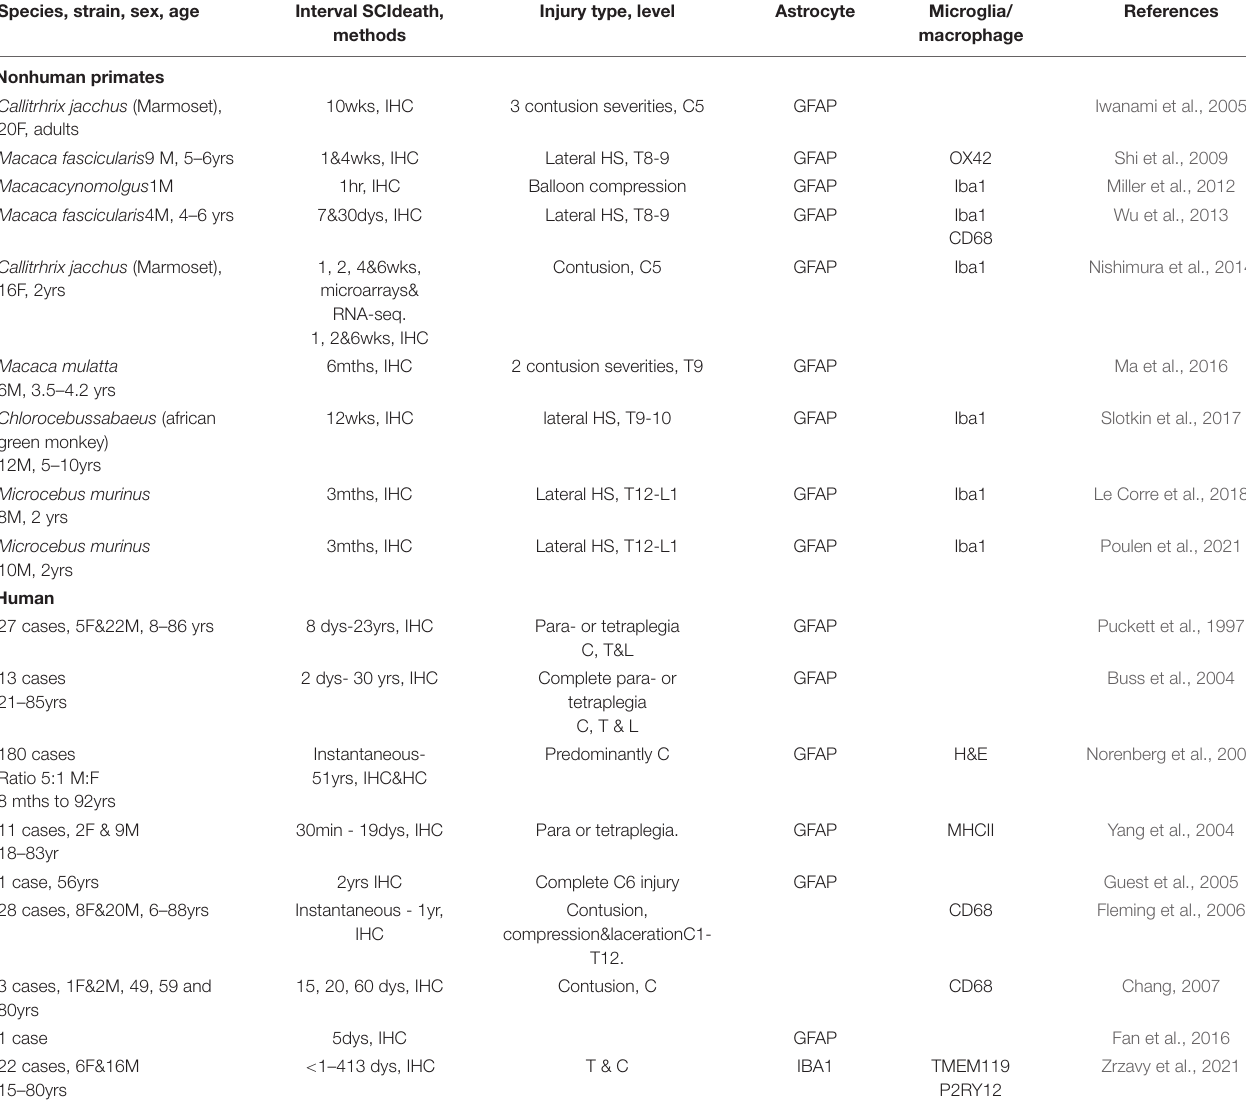
TABLE 3 | Studies demonstrating roles of the glial and immune cells after SCI in primates. Species, strain, sex,